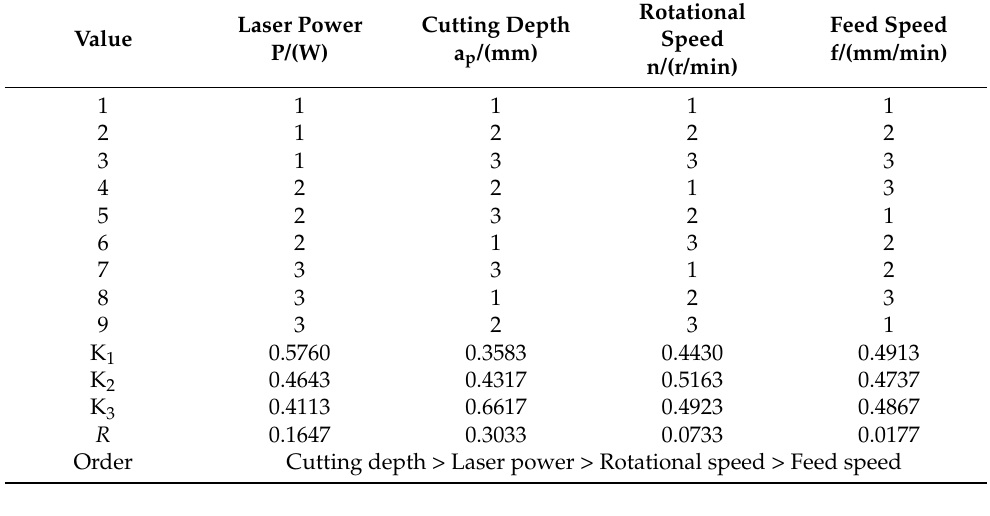
Table 6. Range analysis of surface roughness.